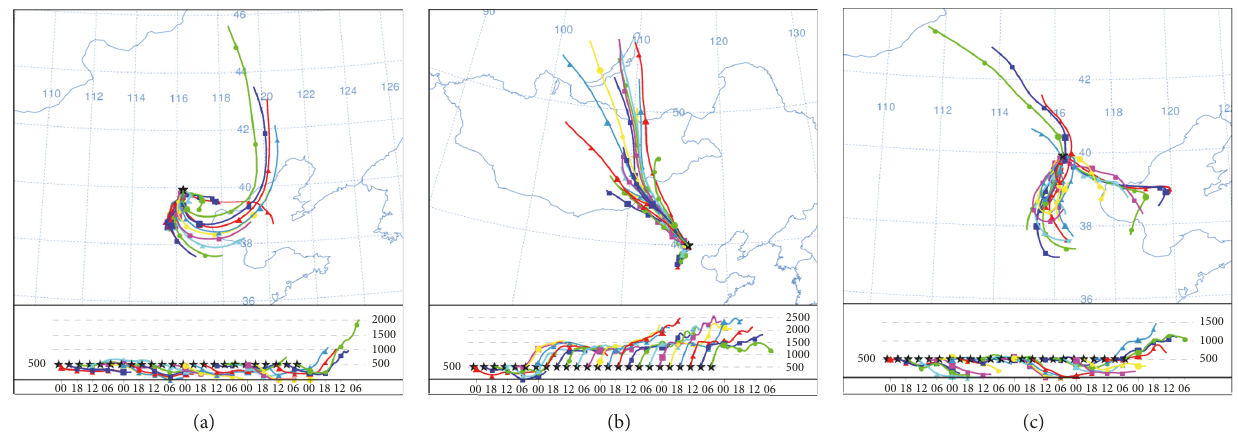
Figure 4: Three transport corridors, namely, southeast branch (a), northwest branch(b), and southwest branch (c), tracked by 24 h backward trajectories of air masses in Jing-Jin-Ji